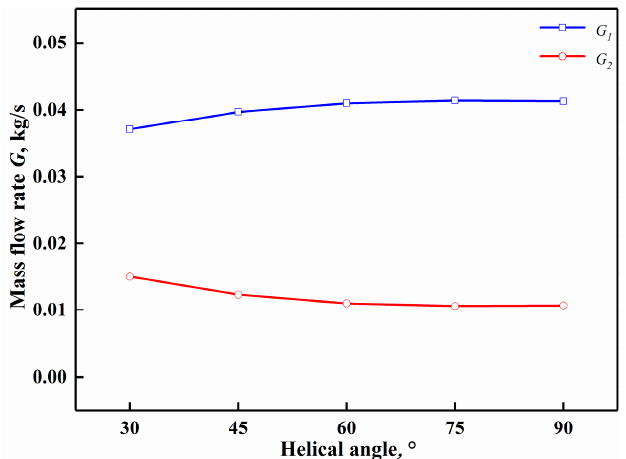
Figure 8. Distribution of gas mass flow in the drill bit.